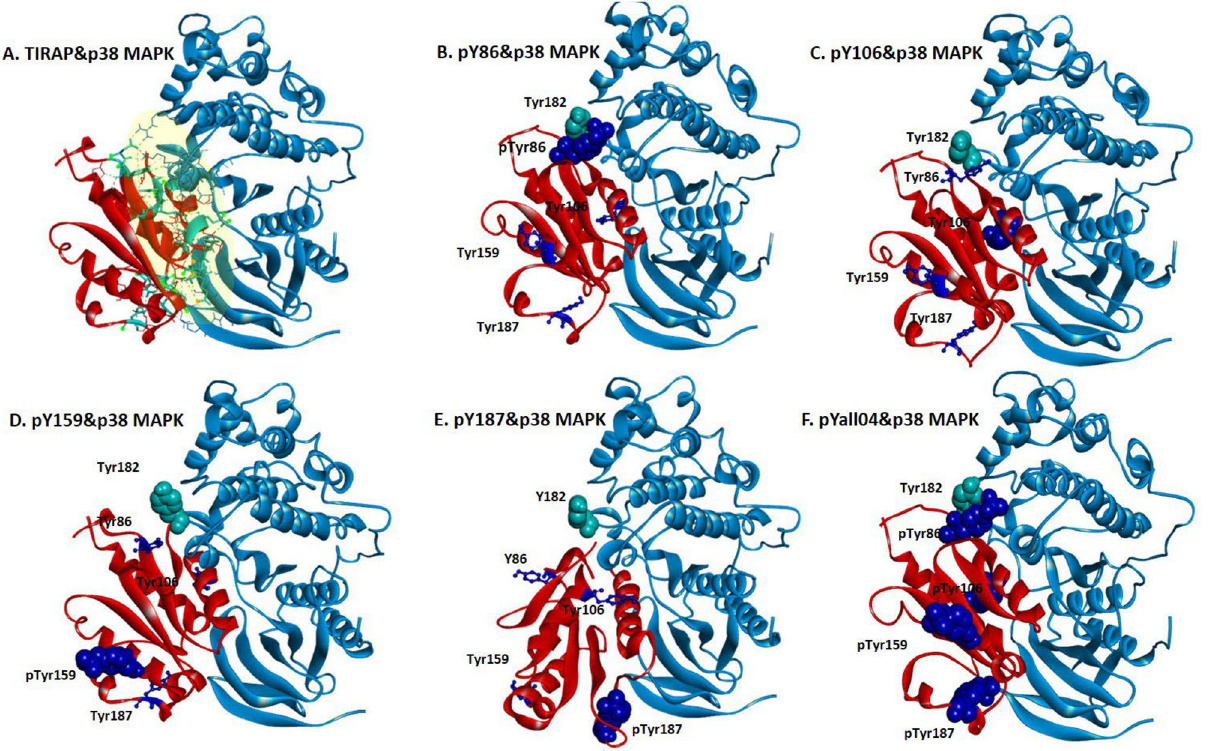
Figure 3. The molecular docking complex of p38 MAPK and tyrosine-phosphorylated (pY) TIRAP from the HADDOCK 2.4 tool. The complex of non-phosphorylated TIRAP (red) and p38 MAPK (light blue) ( A ) was further investigated in a comparative analysis with a docking complex of p38 MAPK (light blue) and TIRAP (red) phosphorylated tyrosine pY86 (dark blue) ( B ), pY106 (dark blue) ( C ), pY159 (dark blue) ( D ), pY187 (dark blue) ( E ) and all four phosphorylated site pYall04 (dark blue) ( F ), respectively. The complexes were the top pose result of HADDOCK 2.4 docking, and the images were prepared using a Discovery studio Visualizer v21.1.0.20298. The tyrosine residues of TIRAP (dark blue) were represented in ball and stick format whereas the phosphorylated tyrosine residue in TIRAP (blue) and p38 MAPK (cyan) were represented in cpk (Corey- Pauling-Koltun) format. The interacting interface residues between both proteins were analyzed with the 3 Å region in a Chimera v1.13.1 tool (Supplementary Table